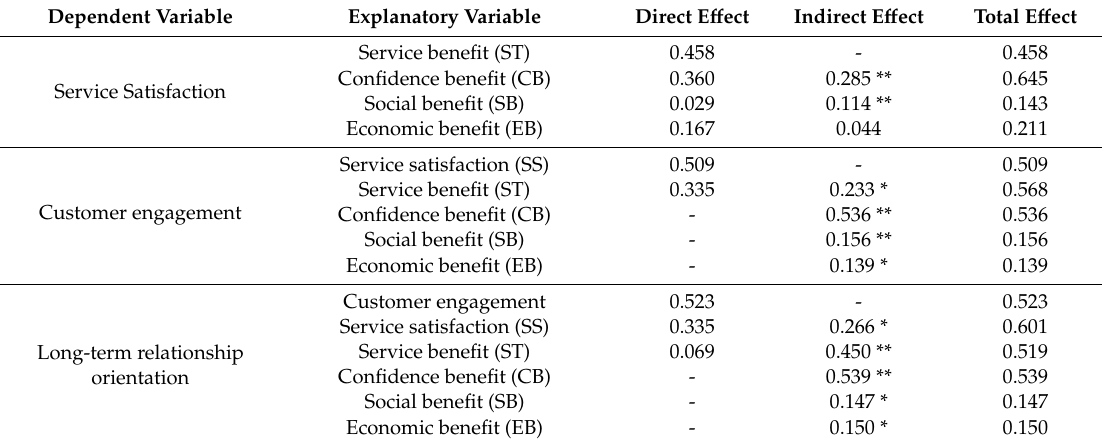
Table 6. Direct and indirect e ff ects analysis